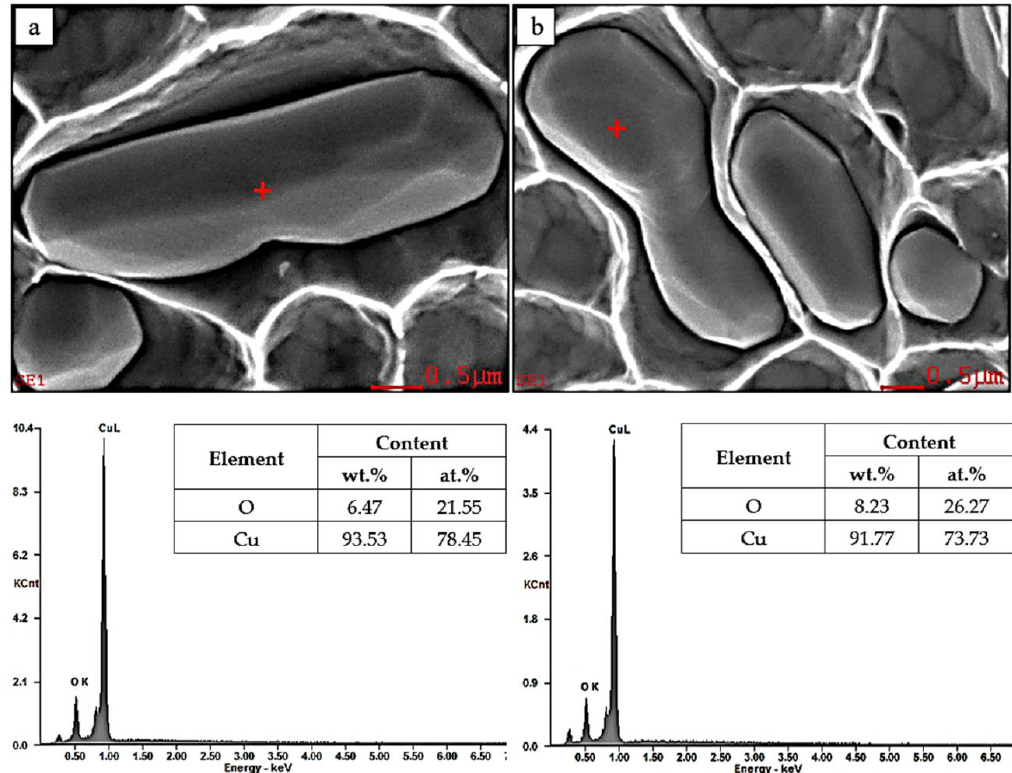
Figure 4. EDX analysis of the ETP grade copper strand with red cross marking the place of the chemical composition analysis and X-ray spectra of these points attached. SEM, SE, magnification ×10,000.